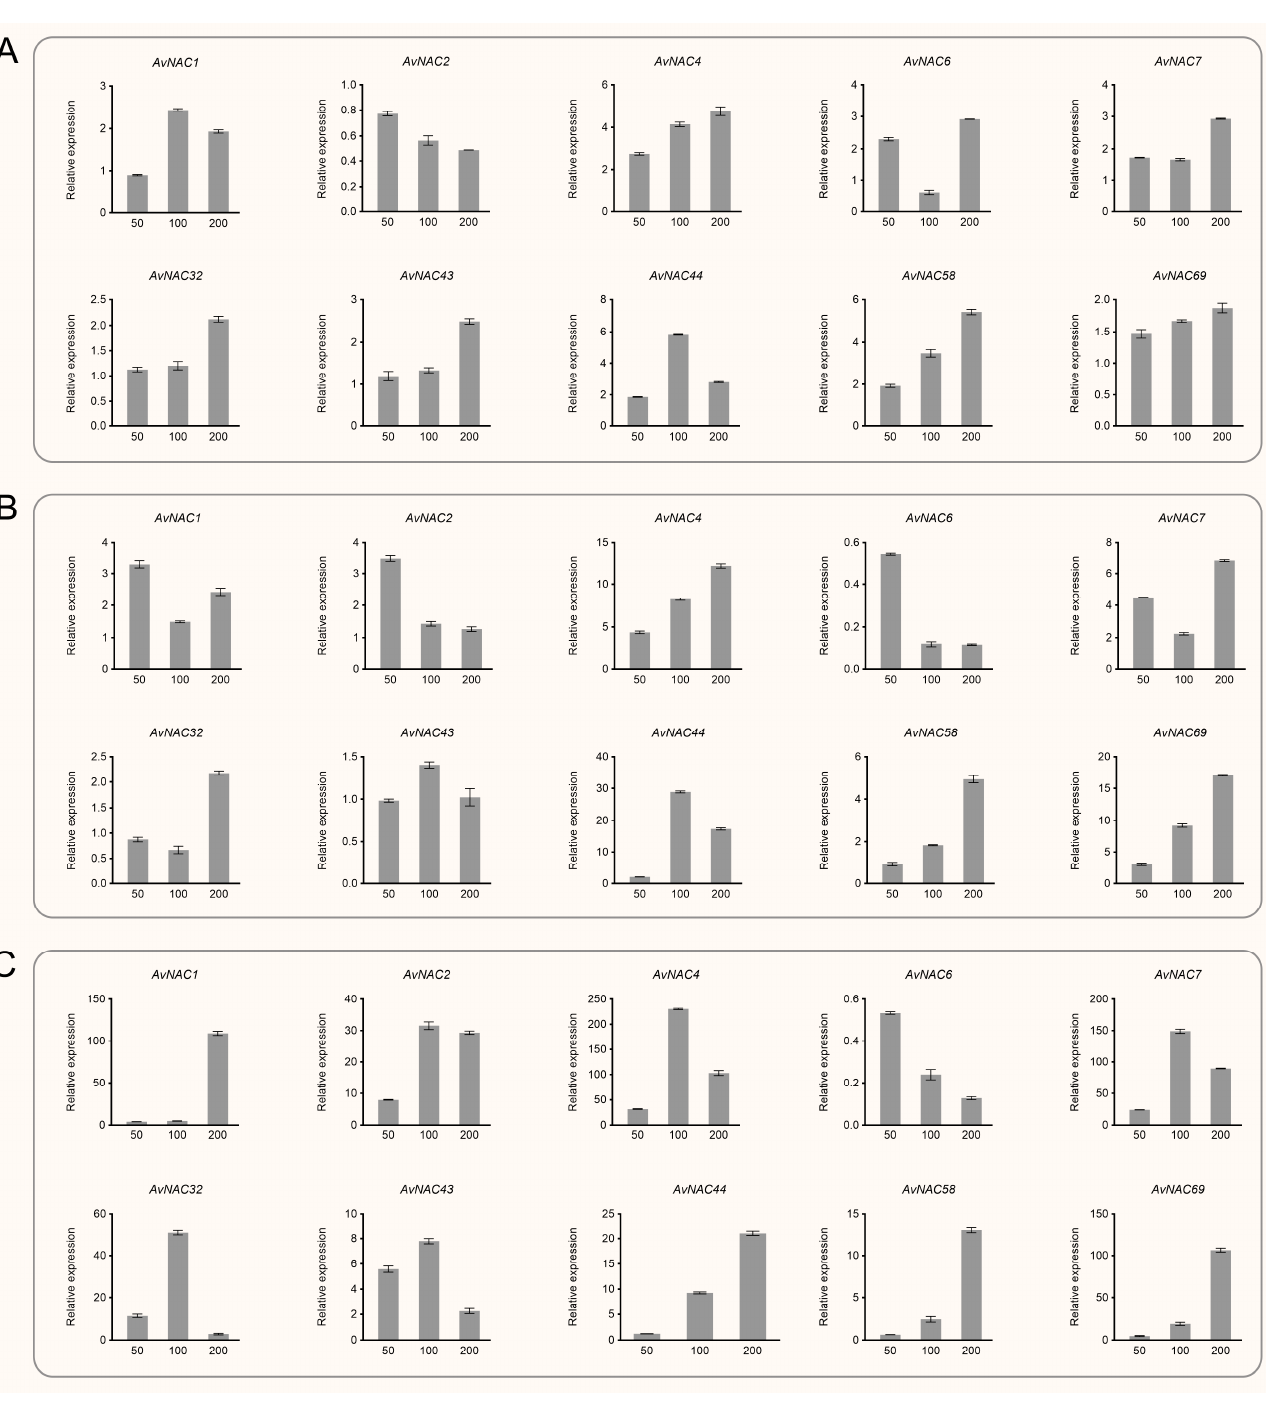
Figure 9. Relative expression of selected AvNAC genes in various tissues of A. venetum under salt stress (0, 50, 100, 200 mM NaCl treatment). ( A ) Leaf. ( B ) Stem. ( C ) Root.